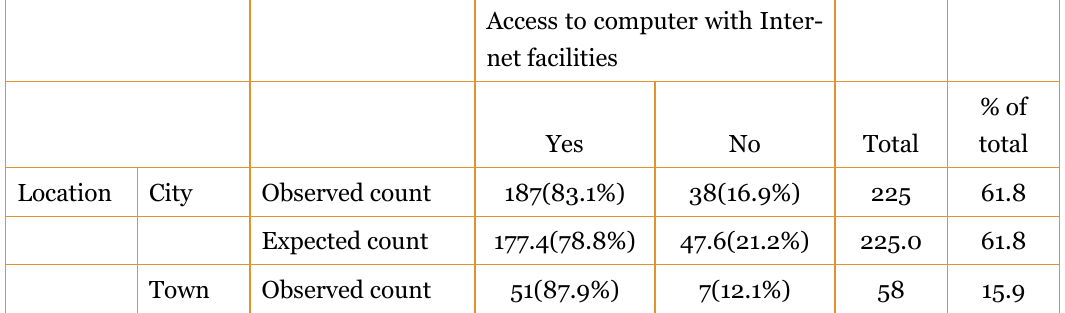
Access to computer with